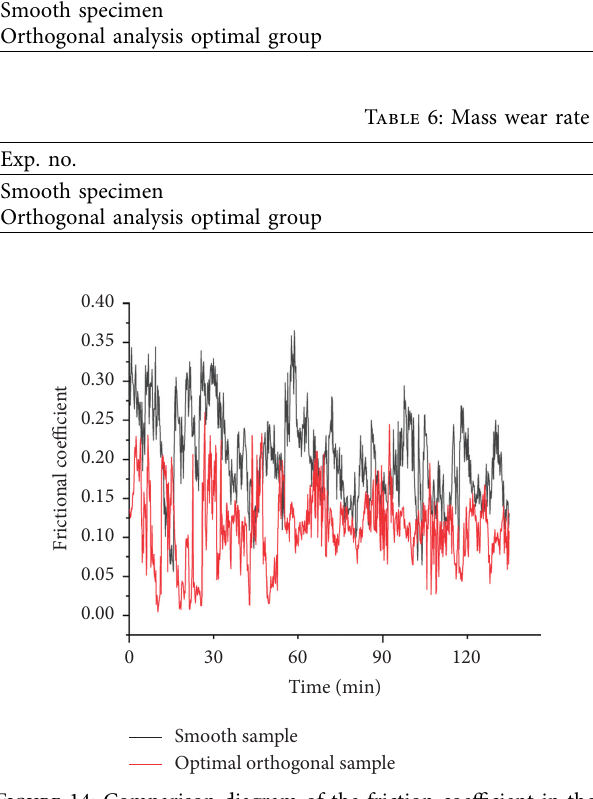
Figure 14: Comparison diagram of the friction coefficient in the dry friction